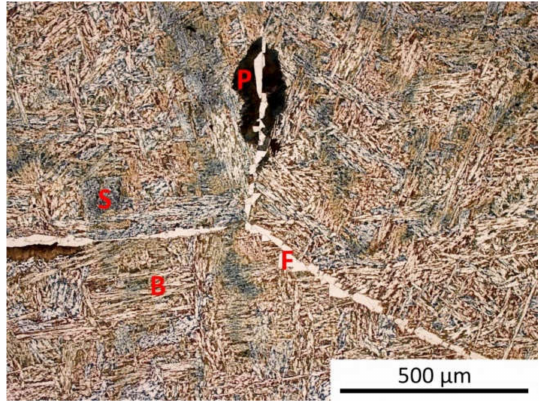
Figure 5. Structure of the sample quenched from a heating temperature of 650 ◦ C—bainite ( B ), ferrite ( F ) and perlite ( P ); dendritic segregations ( S ) are grey (light